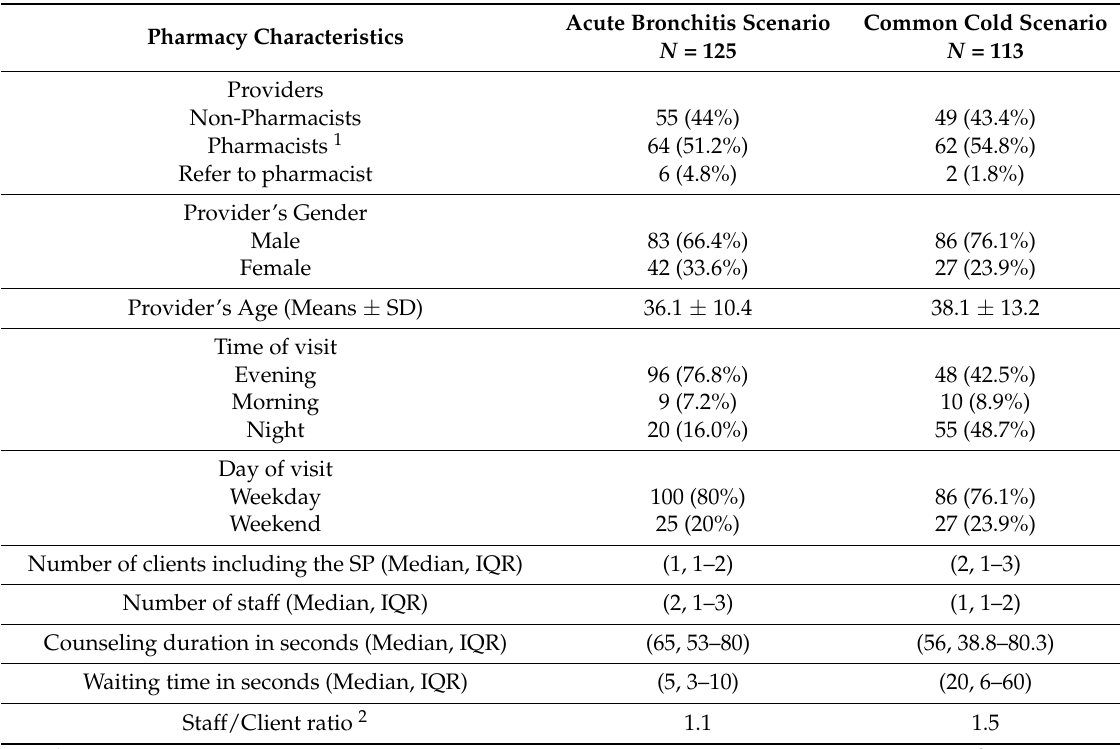
Table 1. Characteristics of pharmacy providers responding to simulated patient